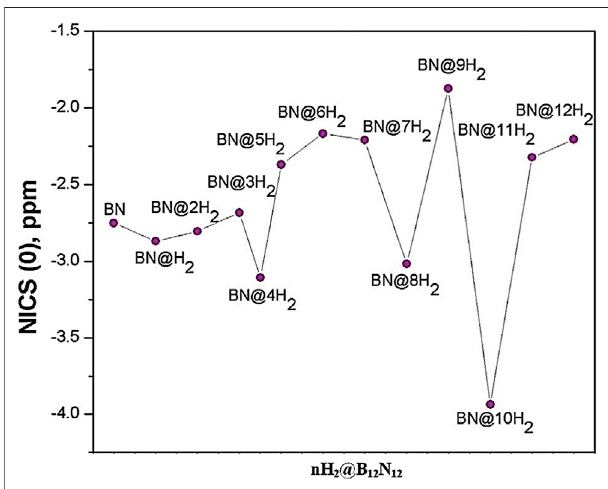
FIGURE12| NICS(0)pro fi leofallthehydrogentrappedB 12 N 12 species. (Reproduced from Giri et al., 2011b with permission from Taylor & Francis. Copyright © 2011 Santanab Giri et